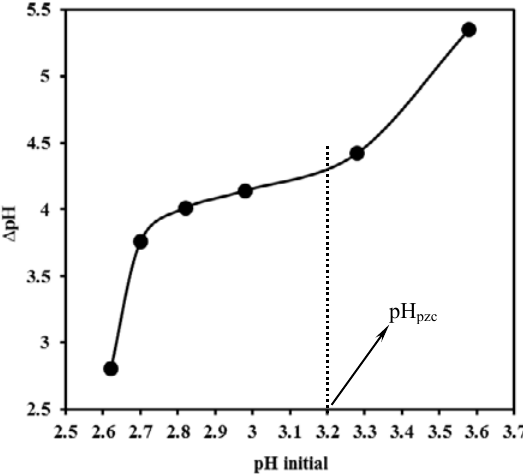
Fig. 7. Changes in position and intensity of the visible region spectrum (λ Fig. 8: